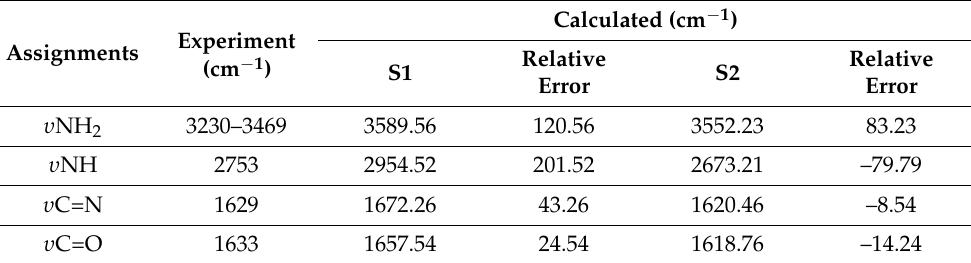
Table 4. The most common experimental and calculated vibrational frequencies (cm − 1 ) and assign- ments of the complex at ”B3LYP/6-311G(d,p)”.